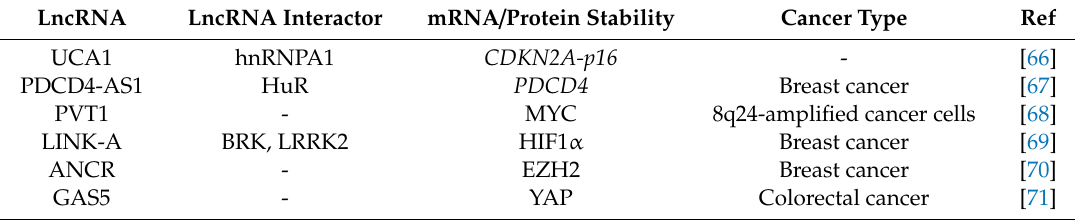
Table 3. LncRNA control of mRNA and protein